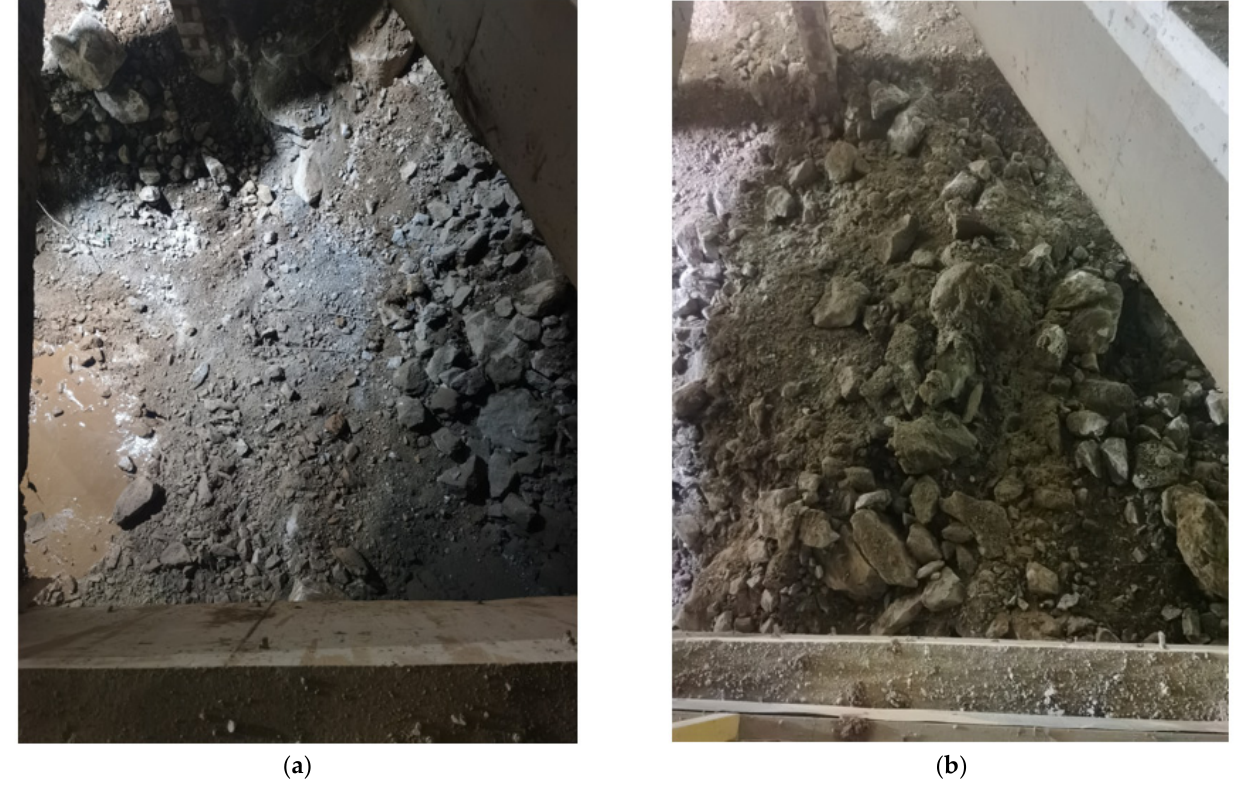
Figure 18. Comparison of blasting effects before and after on-site grouting. ( a ) Rock-breaking effect before grouting; ( b ) rock-breaking effect after grouting.